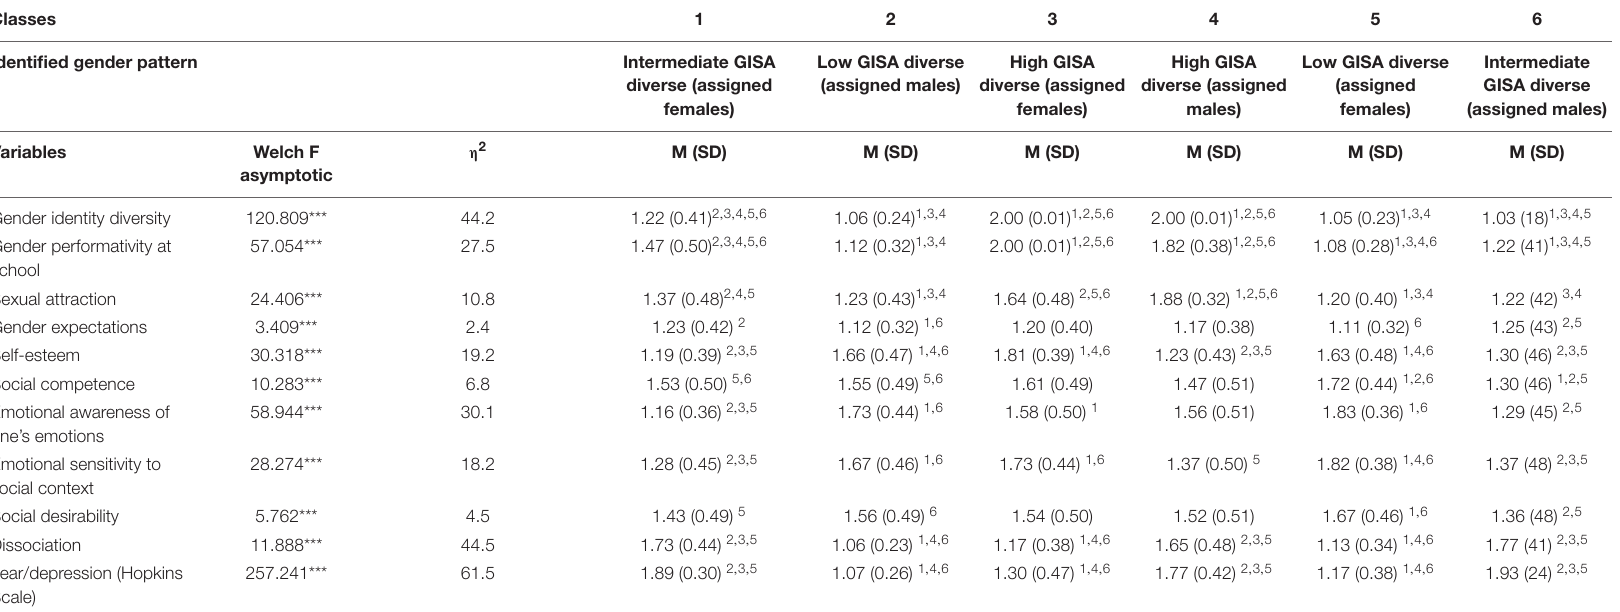
TABLE 1 | Variance analysis with Games–Howell post hoc test of the 11 analyzed LCA variables in the six patterns (three classes solution). Classes Identified gender pattern